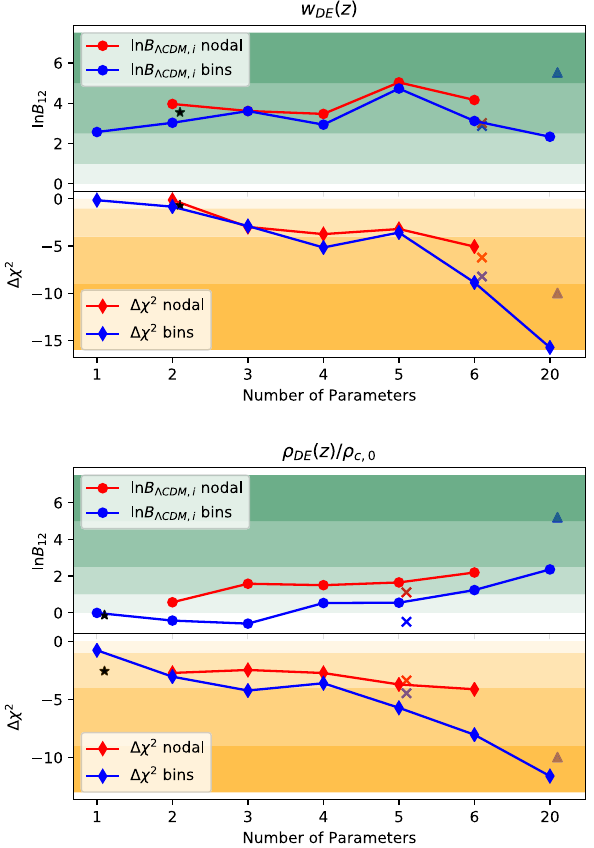
Fig. 2 In this graph we show the differences in the (cid:7)χ 2 and the Bayes factor between (cid:3) CDM and our reconstructions for w DE ( z ) and ρ /ρ DE c , 0 . The green shades show the strength-of-evidence according to the Jeffrey’s scale and the orange shades show the 1 to 4- σ levels (cid:11) | (cid:7)χ 2 | . Ideally we want the upper of statistical significance S / N ≡ markers to stay as close as possible to the black line at 0 (preferably to cross it), which it is an indication of a better Bayes’ factor, and the lower ones to be far away from zero, which indicates a better fit to the data. The stars indicate the fitness of the reconstruction of the CPL EoS (top) and the energy density with a sigmoid (bottom), the crosses indicate the internal z i reconstructions and the triangles the reconstructions with 20 bins plus correlation function. The binning reconstructions are plotted with blue lines, whereas the nodal with red lines